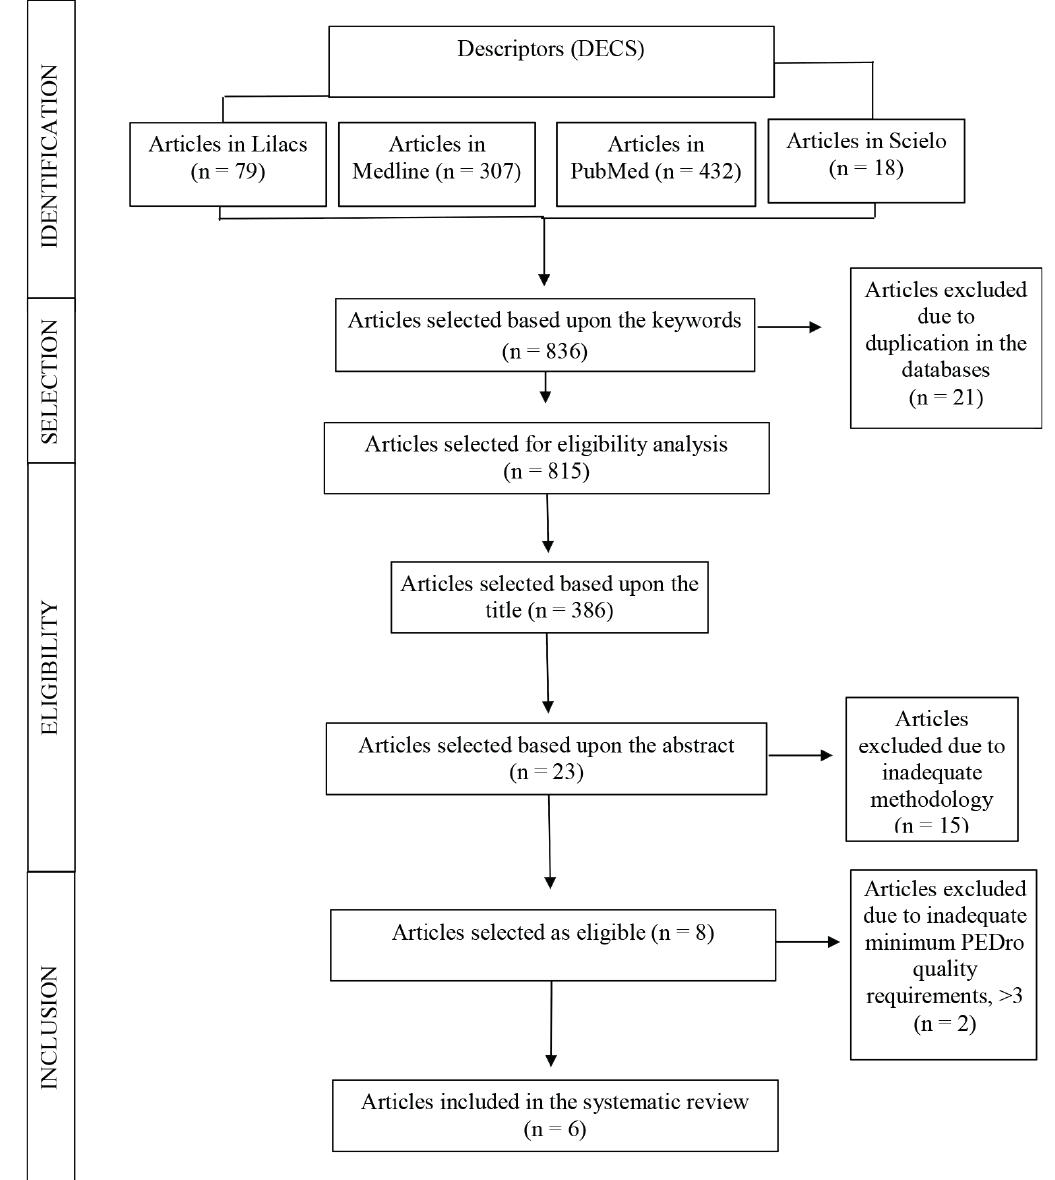
Figure 1 - Flowchart of the article selection steps in the systematic